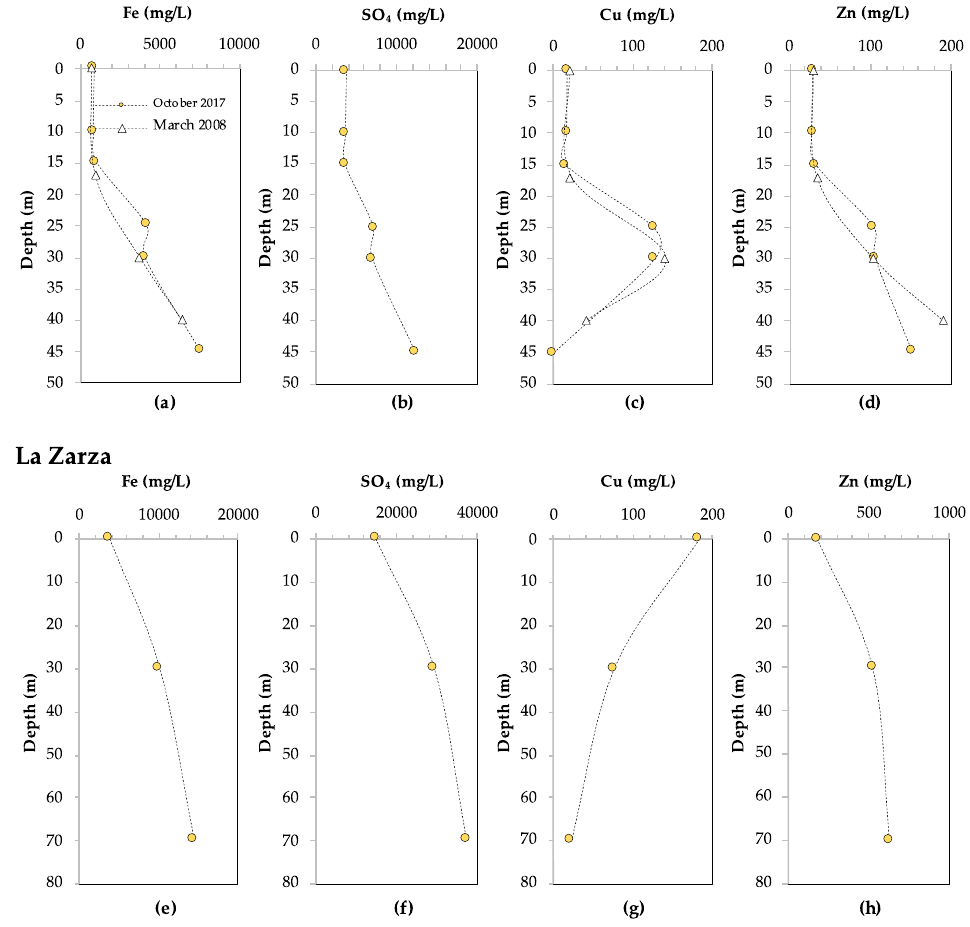
Figure 3. Depth profiles of total dissolved iron (Fe), sulfate (SO 42 − ), copper (Cu 2+ ), and zinc (Zn 2+ ) in mg/L in Filón Centro ( a – d ) and La Zarza ( e – h ), as measured in October 2017 (yellow circles). Data from FC are compared with chemical data from March 2008 [3,36].